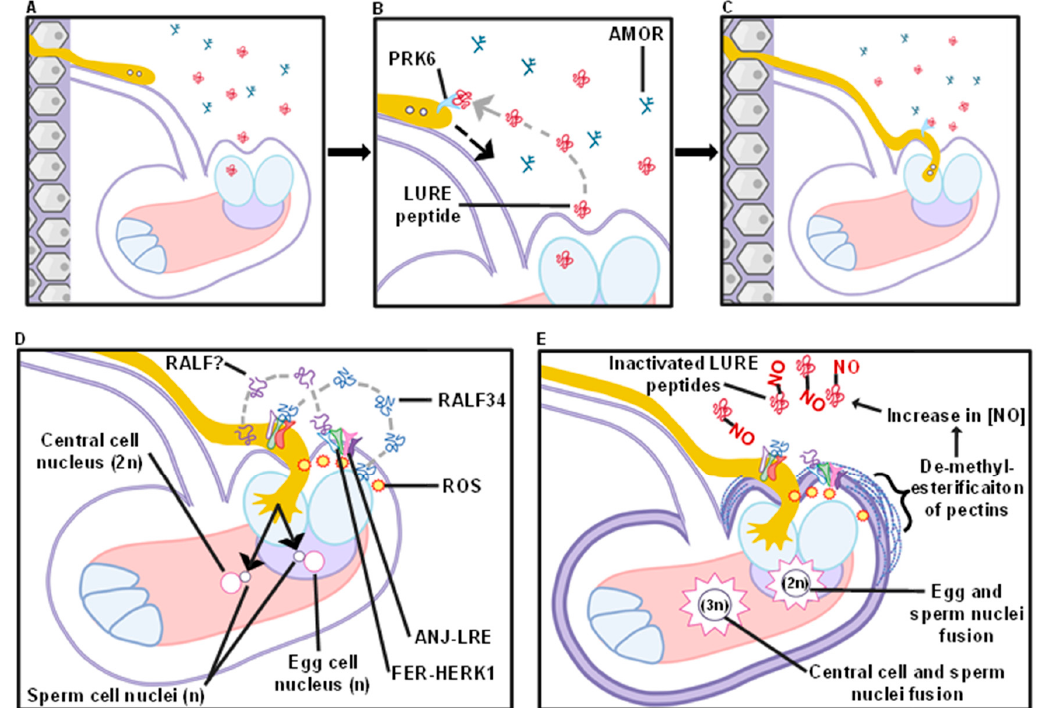
Figure 3. Schematic of a pollen tube being attracted to an ovule and synergid penetration. ( A ) The pollen tube exits the transmitting tract and moves along the funiculus. ( B ) While approaching the ovule, PRK6, a receptor-like kinase, binds LURE peptides secreted by the synergid cells, acting as a positive reinforcement signal. AMOR glycans, potentially attached to AGPs, potentiate this attractive signal. ( C ) The pollen tube enters the ovule by penetrating a synergid cell. ( D ) As the pollen tube penetrates the filiform apparatus, and subsequently the synergid, it is prompted to burst. The pollen tube’s ANX1/2-BUPS1/2-LLG2/3 signaling complex binds RALF34, secreted by the filiform apparatus, and the ovule’s FER-HERK1/ANJ-LRE signaling complex potentially binds unidentified RALFs, secreted by the pollen tube. FER-HERK1/ANJ-LRE signaling results in Reactive Oxygen Species (ROS) accumulation in the filiform apparatus, facilitat- ing pollen tube bursting. ( E ) Sperm cell fuses with the egg and central cells to form the new embryo and endosperm tissue, respectively. Pectins surrounding the ovule become de-methylesterified. Nitric oxide (NO) species are released into the surrounding area. NO species nitrosate and inactivate LURE peptides, working synergistically with the rigidifying pectin to prevent